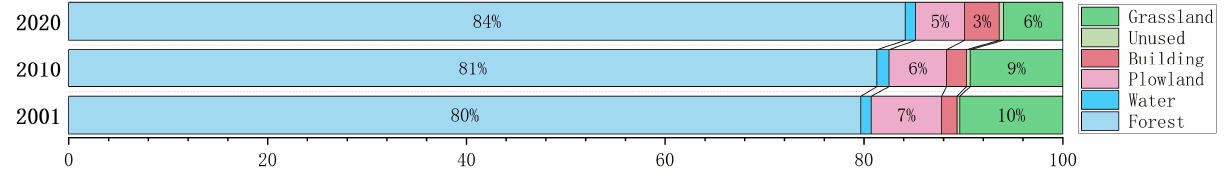
Figure 5. Changes in the area proportion of catchments from 2001 to 2020.